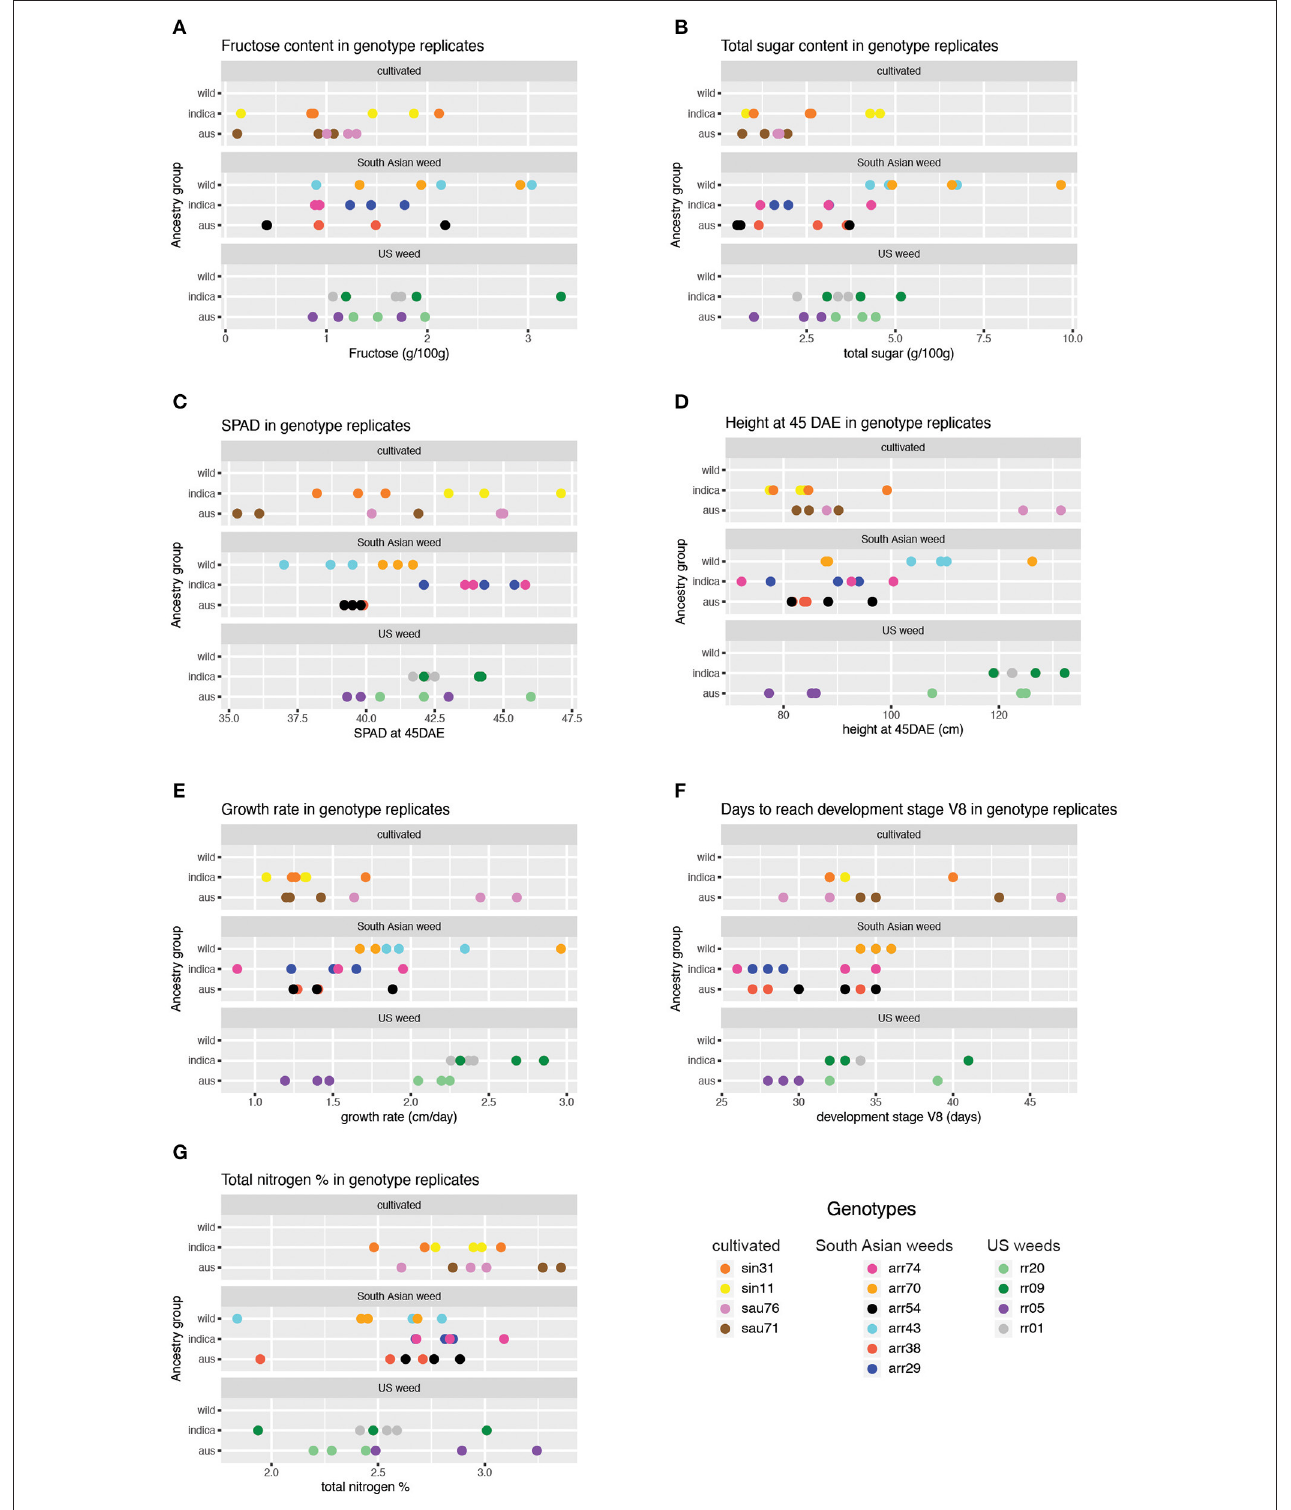
FIGURE 2 | Trait values obtained across genotypes and replicates for phenotypes showing significant results in the mixed model analysis ( Table 2 ). Results for only two of the five sugar traits are shown, given similar results across sugar traits for the wild ancestry group. (A) Fructose content across genotype replicates. (B) Total sugar content across genotype replicates. (C) SPAD at 45 DAE across genotype replicates. (D) Height at 45 DAE across genotype replicates (E) . Growth rate across genotype replicates. (F) Days to reach V8 stage across genotype replicates. (G) Total nitrogen percentage across genotype replicates.